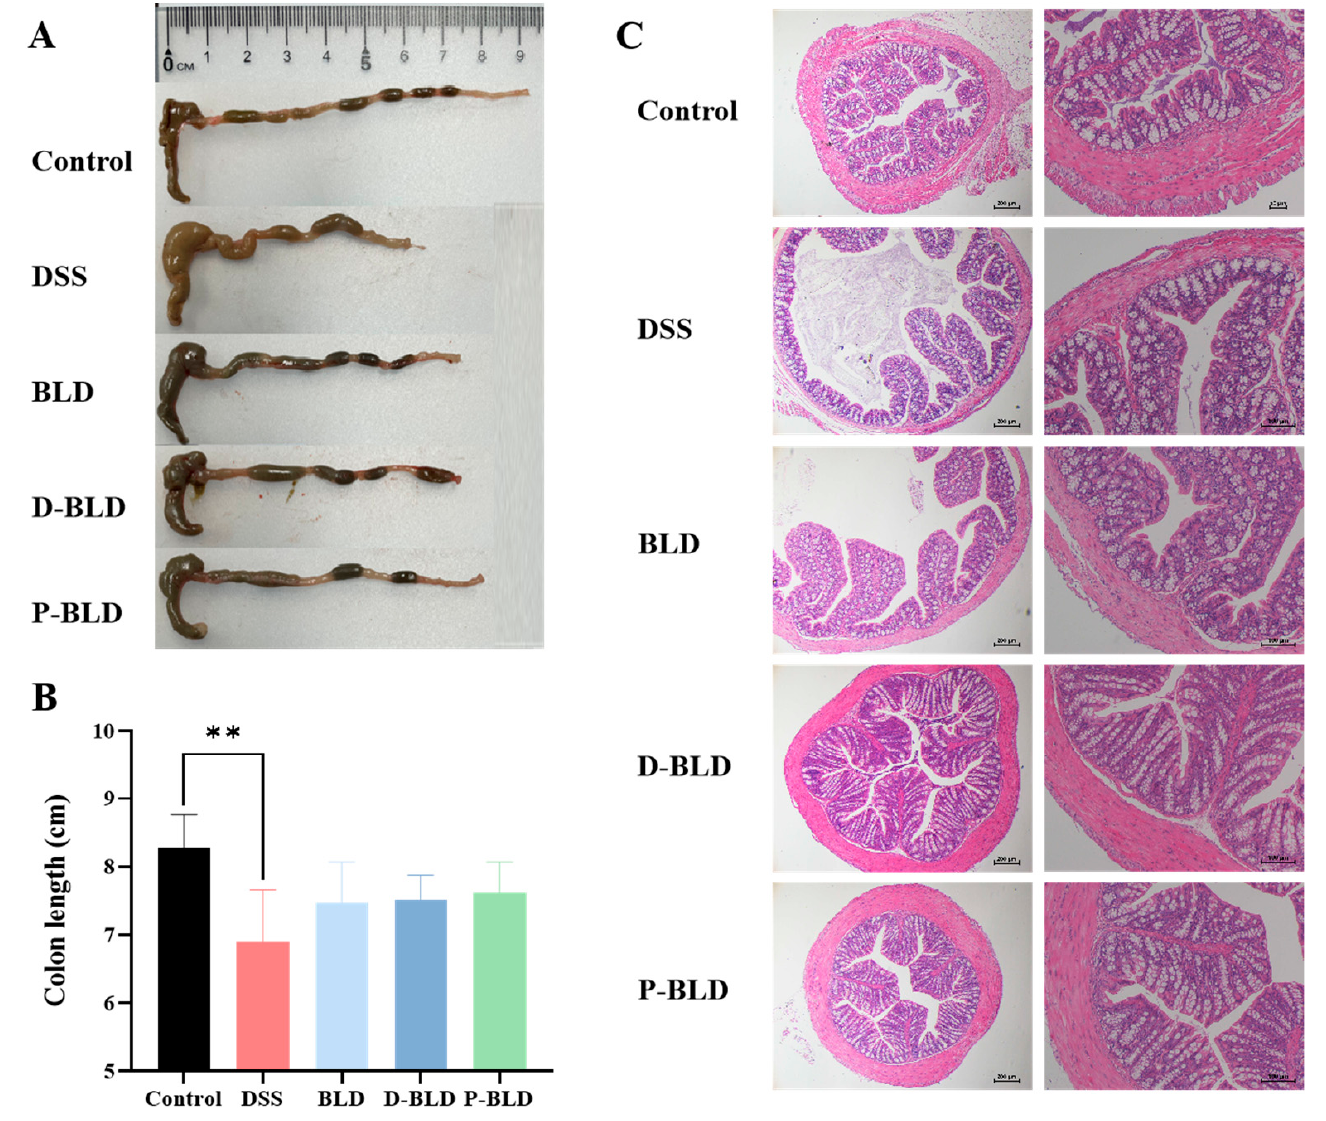
Figure 3. Effects of S. boulardii and its postbiotic elements on colon length and colon tissue structure in mice with DSS-induced colitis. ( A ) Apparent picture of colon tissue. ( B ) length of colon. ( C ) HE staining result of colon tissue. The first column of the scale bar is 200 µ m, and the second column of the scale is 100 µ m. Note: Data are expressed as mean ± SD. Comparison of significant differences between groups is indicated, where ** p < 0.01 compared with Control group.